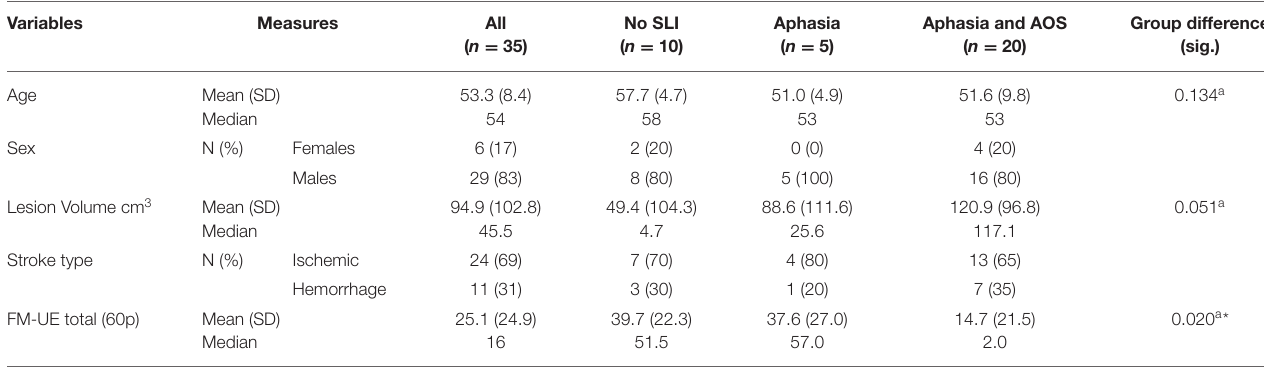
TABLE 1 | Participant characteristics at A1, LH lesioned ( n = 35).